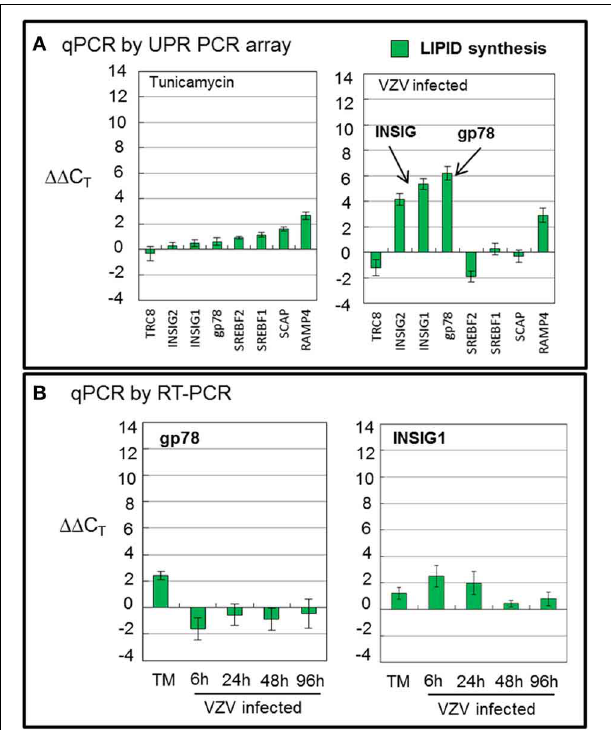
FIGURE 7 | VZV infection downregulated the transcription factor C/EBPb and displayed differential transcription of apoptotic transcripts. Human fibroblast cells (MRC-5) were grown in tissue culture plates then infected with VZV-32 infected MRC-5 cells or treated with tunicamycin (TM), a N-glycosylation inhibitor. At 72 hpi, RNA was processed as described in the legend to Figure 2 . (A) Transcription of apoptotic genes differed considerately between VZV infected cells and tunicamycin treated cells. VZV infected cell transcripts showed very fewer CHOP transcripts when compared to TM treatment; infected cells had more transcripts associated with cellular apoptosis such as HTRA4 and MAP kinases JNK1 and JNK3 . (B) Transcription of cellular transcription factor C/EBP β was significantly downregulated in VZV infected cells as compared to the value in TM treated cells (C) . There was no difference between VZV vs. TM treatment for two protein translation associated transcripts. Error bars correspond to standard deviation when